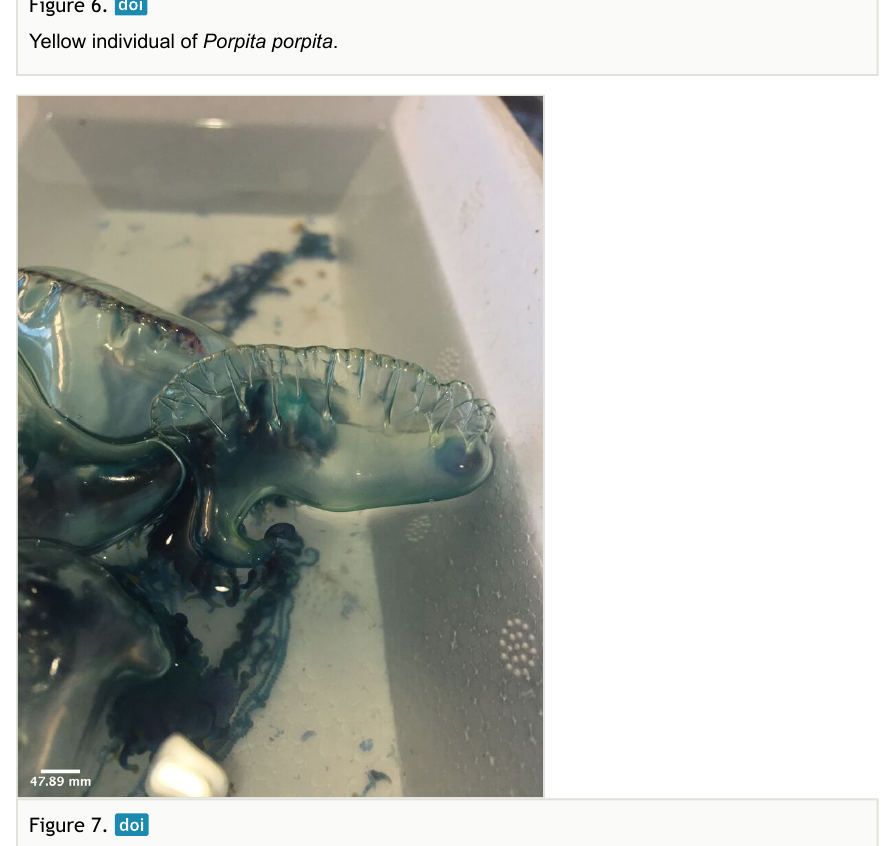
Figure 6. Yellow individual of Porpita porpita .